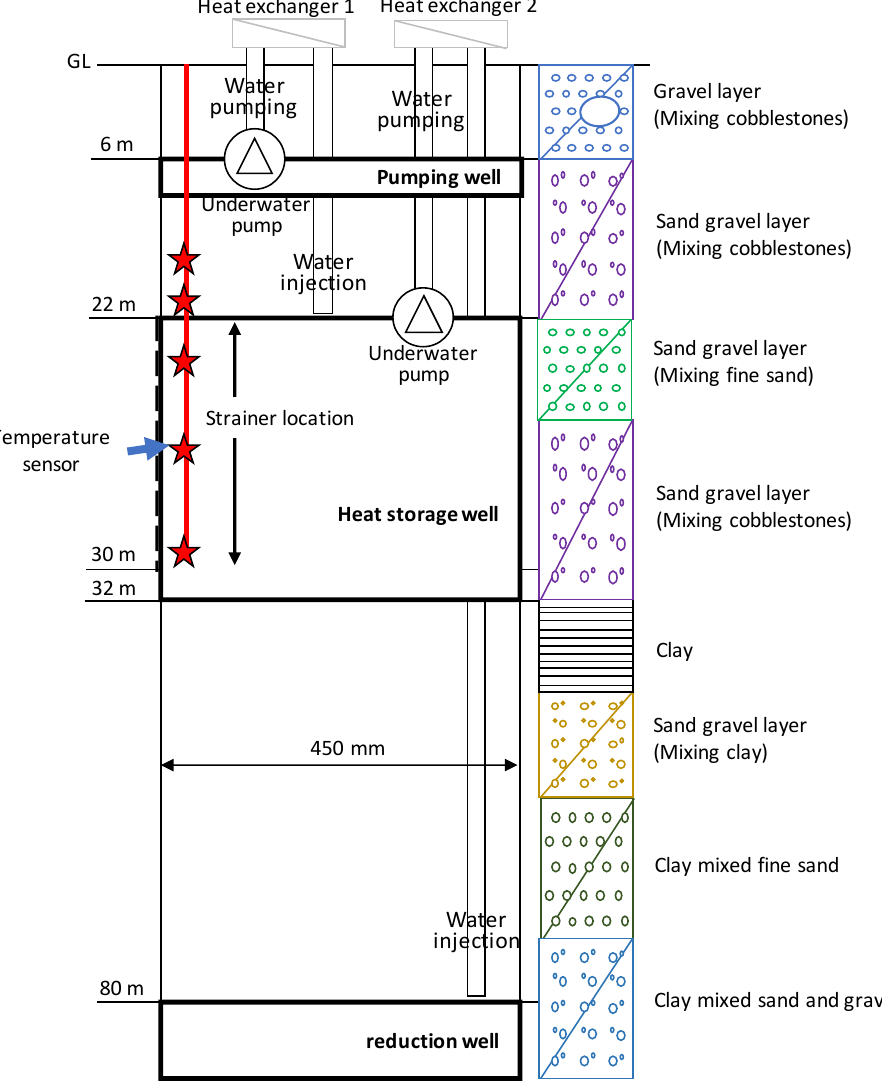
Figure 3. The stratum diagram of the heat storage well.